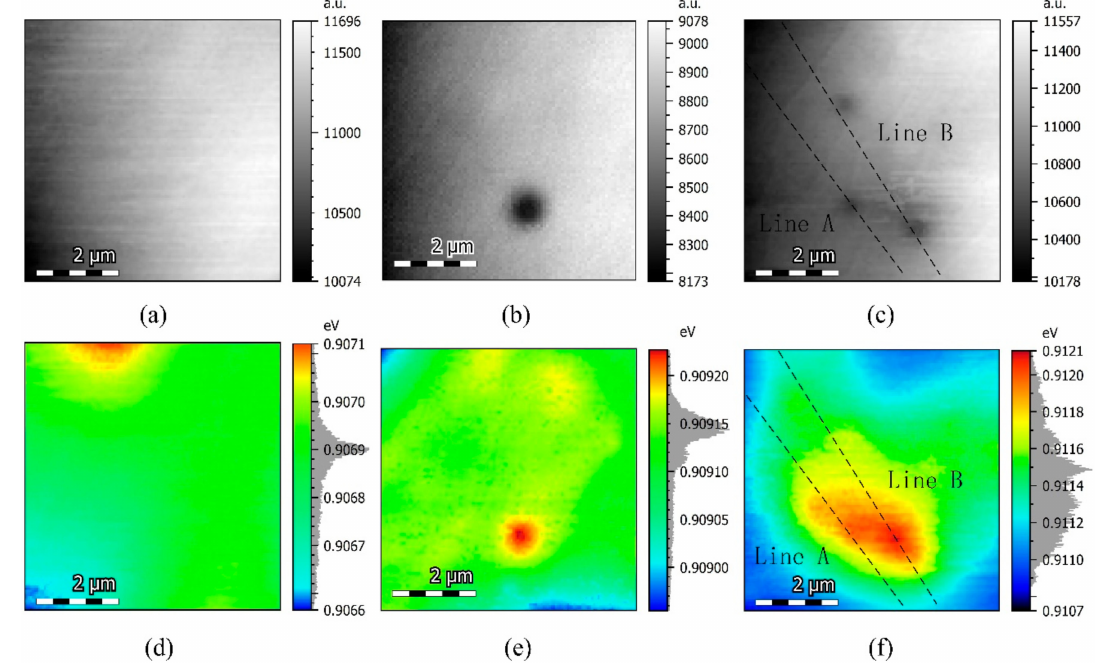
Figure 4. Cathodoluminescent (CL)-integrated intensity mappings of sample ( a ) as grown ( b ) 2 h ( c ) 4 h at the emission energy of Al 0.07 Ga 0.22 In 0.71 As QW at 25 K. Corresponding absolute CL peak energy shift mappings of ( d ) as grown ( e ) 2 h ( f ) 4